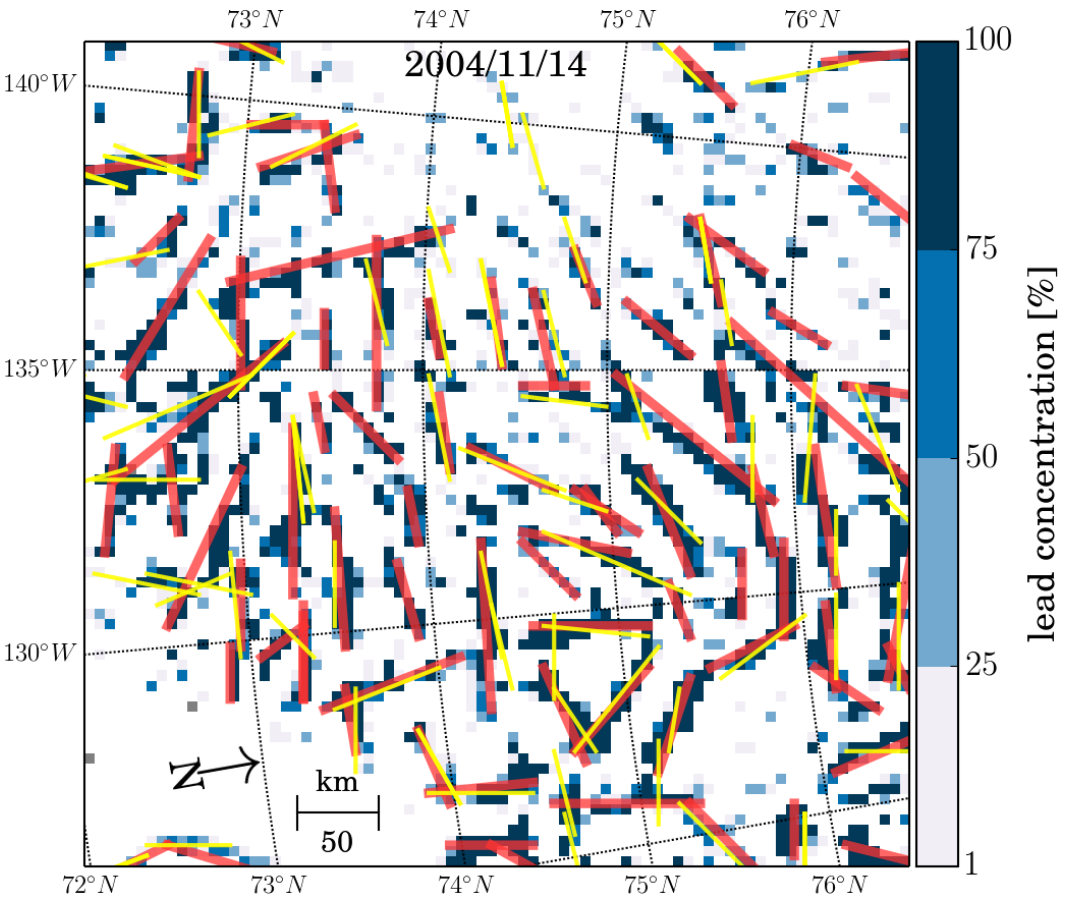
Figure 6. Comparison between reference leads (red) and clustered leads (yellow) detected by the Hough transform in the Beaufort Sea on 14 November 2004.